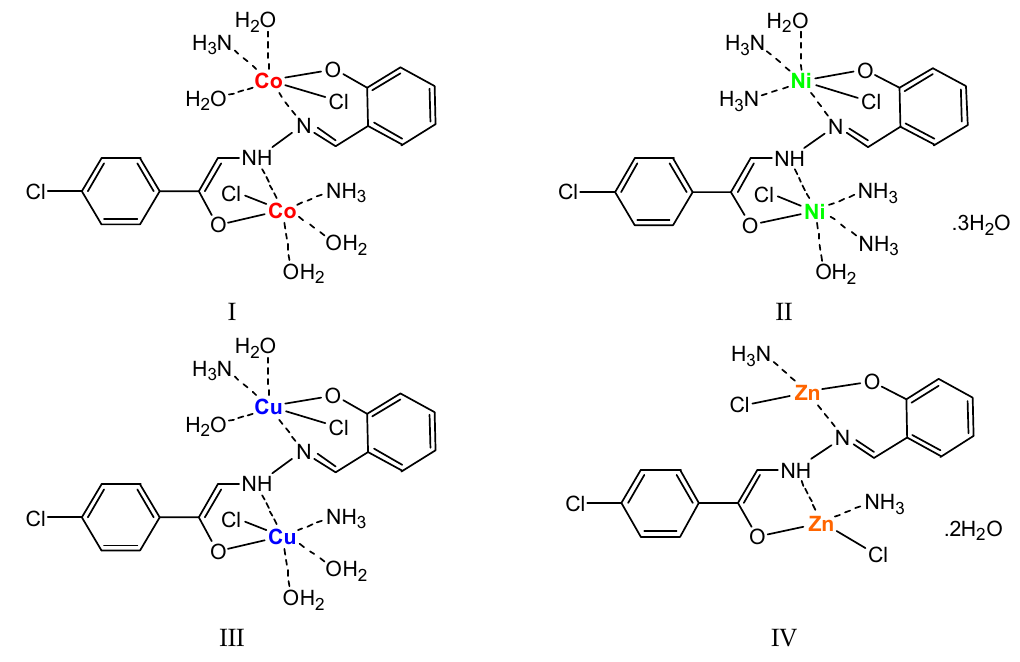
Figure 4. Proposed structures of 2:1 diim complexes.